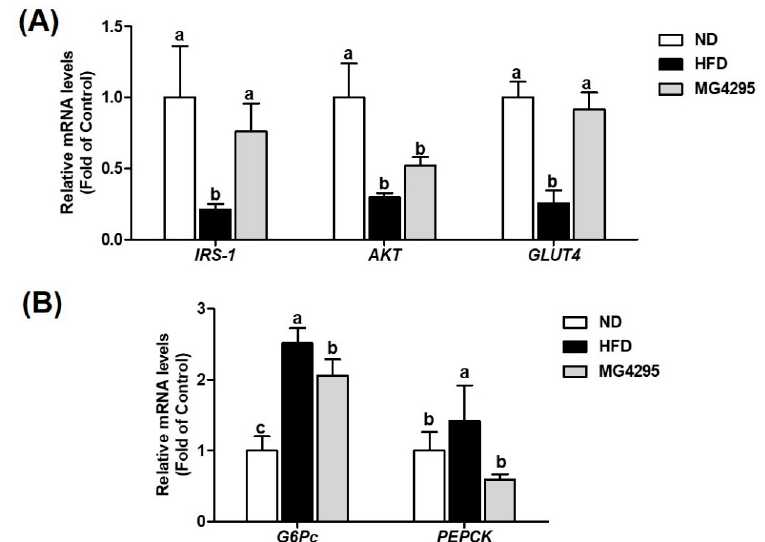
Figure 5. Effect of L. fermentum MG4295 on ( A ) insulin signaling ( IRS-1 and AKT in liver tissues and GLUT 4 in muscle tissues) and ( B ) gluconeogenesis ( G6Pc and PEPCK ) in liver-related mRNA expressions in HFD-induced mice. The results are presented as mean ± SD ( n = 8). Different letters indicate a significant difference at p < 0.05.